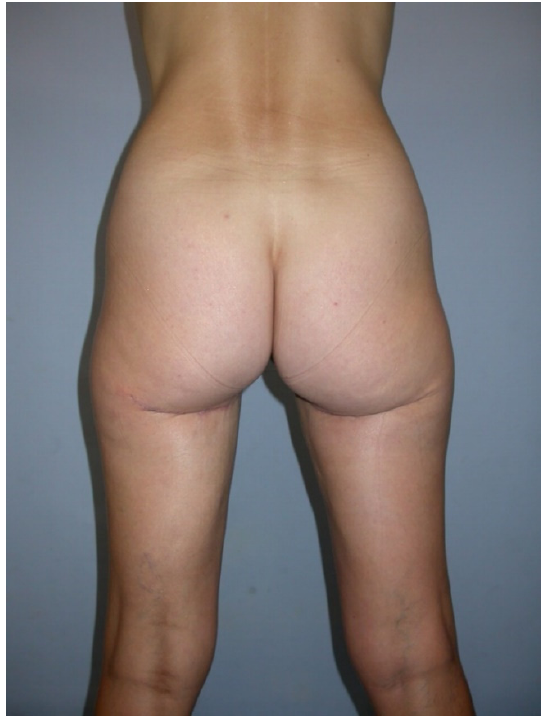
Figure 15. Post-operative result after scar revision with refixation of the gluteal fold.